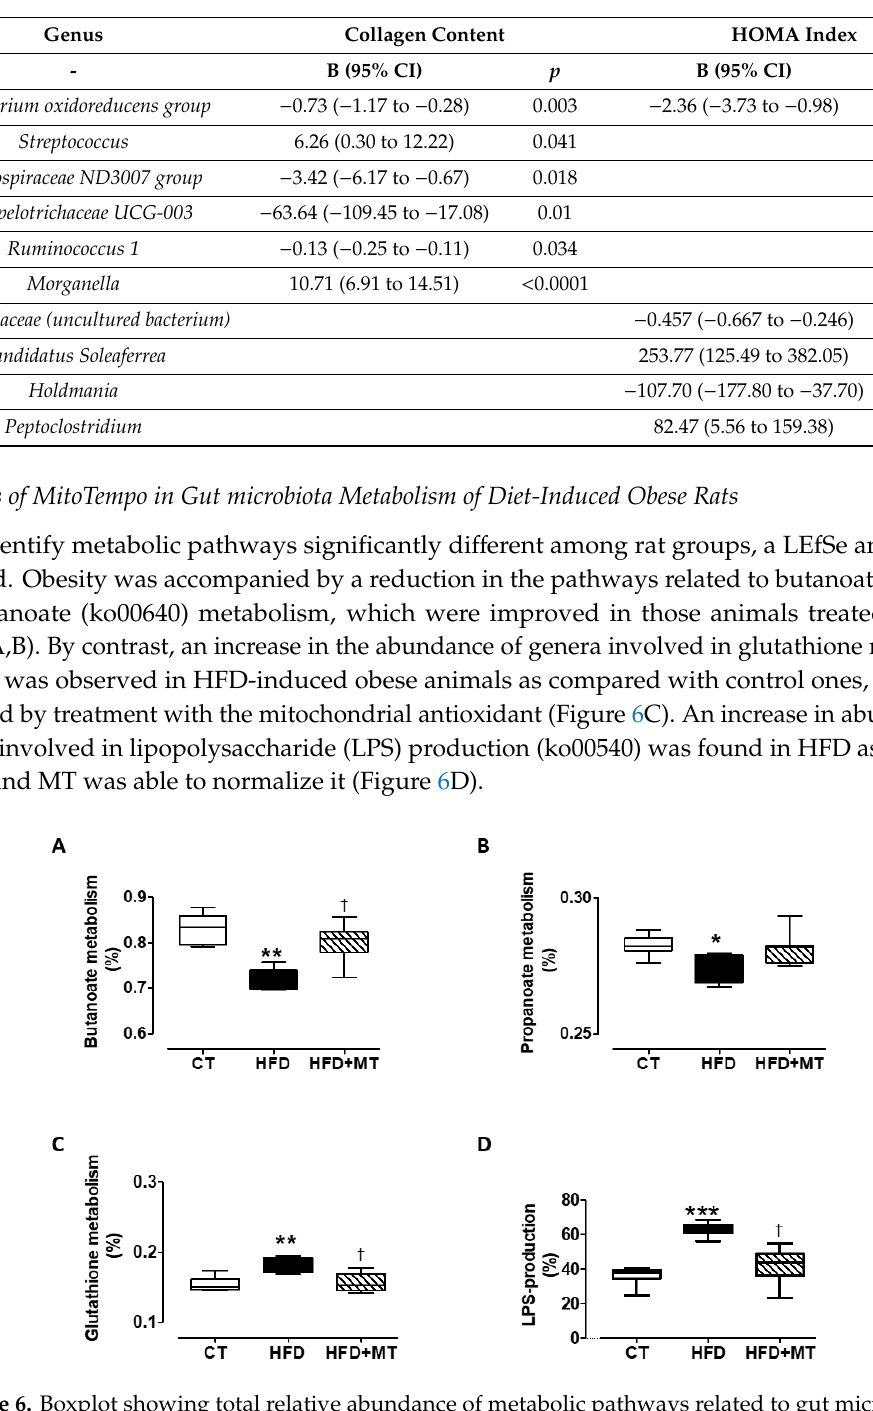
Figure 6. Boxplot showing total relative abundance of metabolic pathways related to gut microbiota in ( A ) butanoate metabolism, ( B ) propanoate metabolism and ( C ) glutathione metabolism and ( D ) percentage of bacteria involved in lipopolysaccharyde (LPS) production in feces from control animals fed a normal chow (CT) and animals fed a high fat diet (HFD) treated with vehicle or with the mitochondrial antioxidant MitoTempo (MT; 0.7 mg / Kg / day i.p). Upper, middle and lower lines represent first quartiles, medians and third quartiles. The whiskers represent a 1.5 * inter-quartile range. Data are expressed as percentage of total reads. * p < 0.05; ** p < 0.01; *** p < 0.001 vs. CT group. † p < 0.05 vs. HFD group.